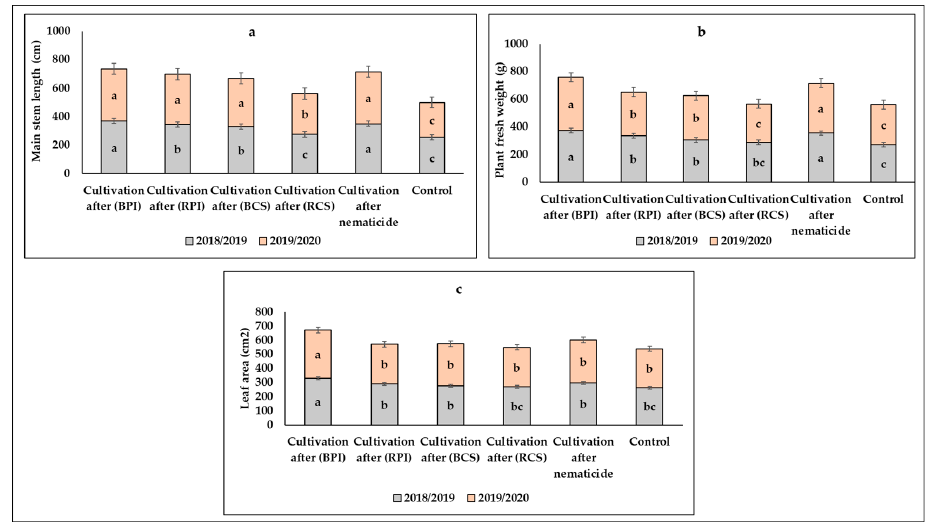
Figure 1. The effects of biofumigation, crop sequence, nematicide treatments compared with control on cucumber vegetative growth, in two seasons 2018/2019 and 2019/2020. (( a ) Main stem length (cm), ( b ) plant fresh weight (g), ( c ) leaf area (cm 2 )). Means (±SE) followed by the same letter are not significantly different at p ≤ 0.05 (LSD test).